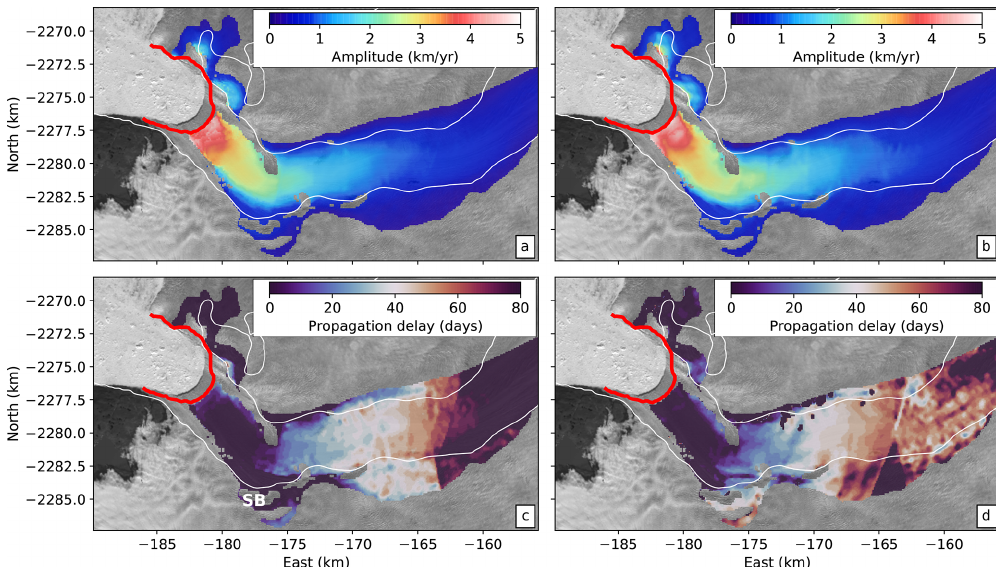
Figure 5. Velocity variation amplitude and phase delay maps for 2012 transient speedup (a, c) and 2017 transient slowdown (b, d) . In (c) , SB indicates the southern bend referred to in the text. Red line indicates winter 2017 terminus position. In addition to the spatial distribution of phase delay and amplitude being consistent for the two events, these transient phase delays show strong similarities with the seasonal phase delay. However, the transient amplitudes show farther-upstream propagation than the seasonal